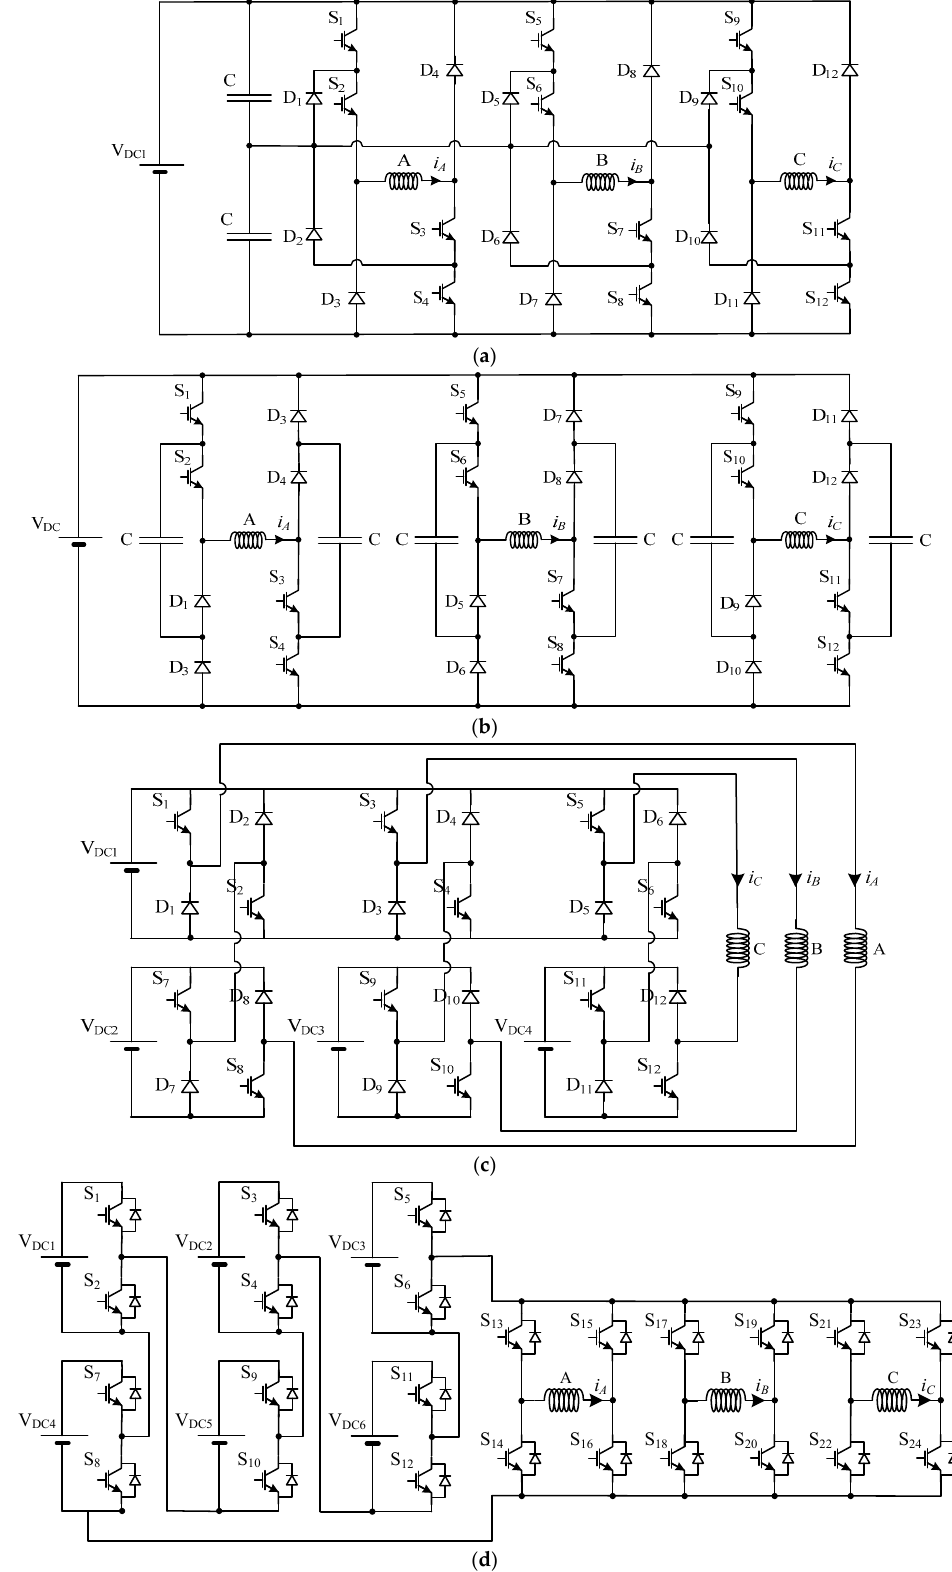
Figure 14. Multilevel converters based on classical topologies ( a ) NPC-AHB converter ( b ) Flying capacitor ( c ) cascaded asymmetrical H-bridge ( d ) modular multilevel converter (MMC).